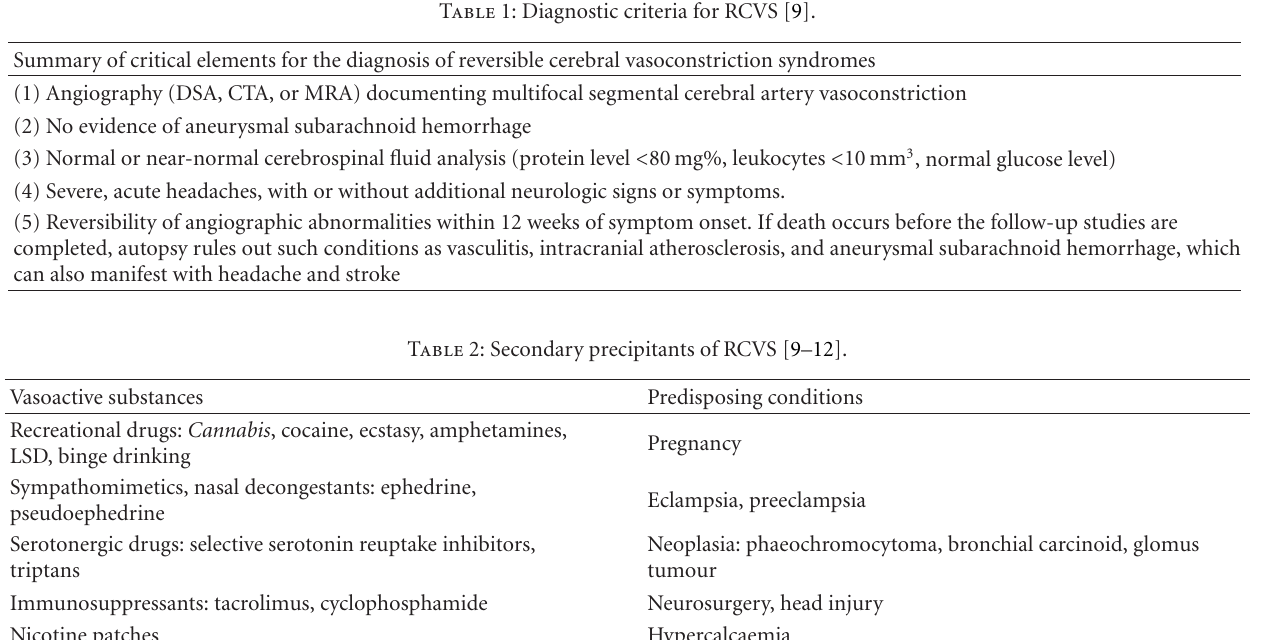
Table 1: Diagnostic criteria for RCVS [9].